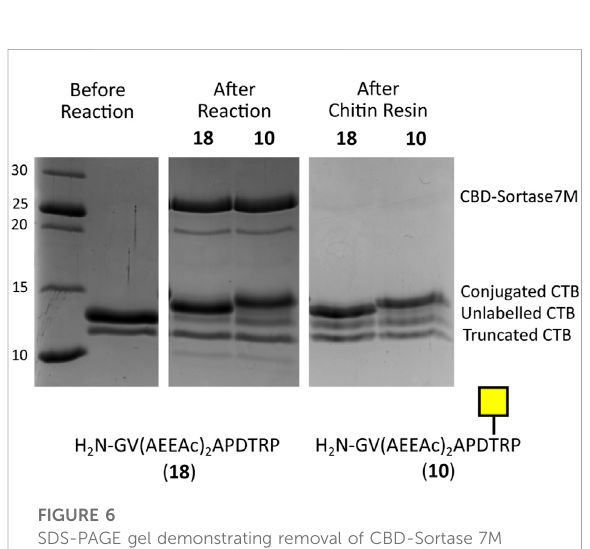
(Figure 5). The ef fi ciency of removing CBD-Sortase 7M from ligation reactions was evaluated by repeating the experiments with SM3 peptide 18 and glycopeptide 10 . After 2 h reaction in the presence of CBD-Sortase 7M, chitin resin was added and the mixture was incubated on ice to minimize any further reaction past the deemed endpoint prior to removal of the resin by centrifugal fi ltration. An analysis of samples before and after use of the chitin resin showed complete removal of the CBD-Sortase 7M, and no